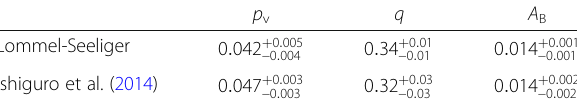
Table 3 Albedo quantities of Ryugu computed using the Lommel-Seeliger model and by Ishiguro et al. (2014). p v is the geometric albedo, q is the phase integral, and A B is the spherical Bond albedo. Table from Le Corre et al. (2018) p